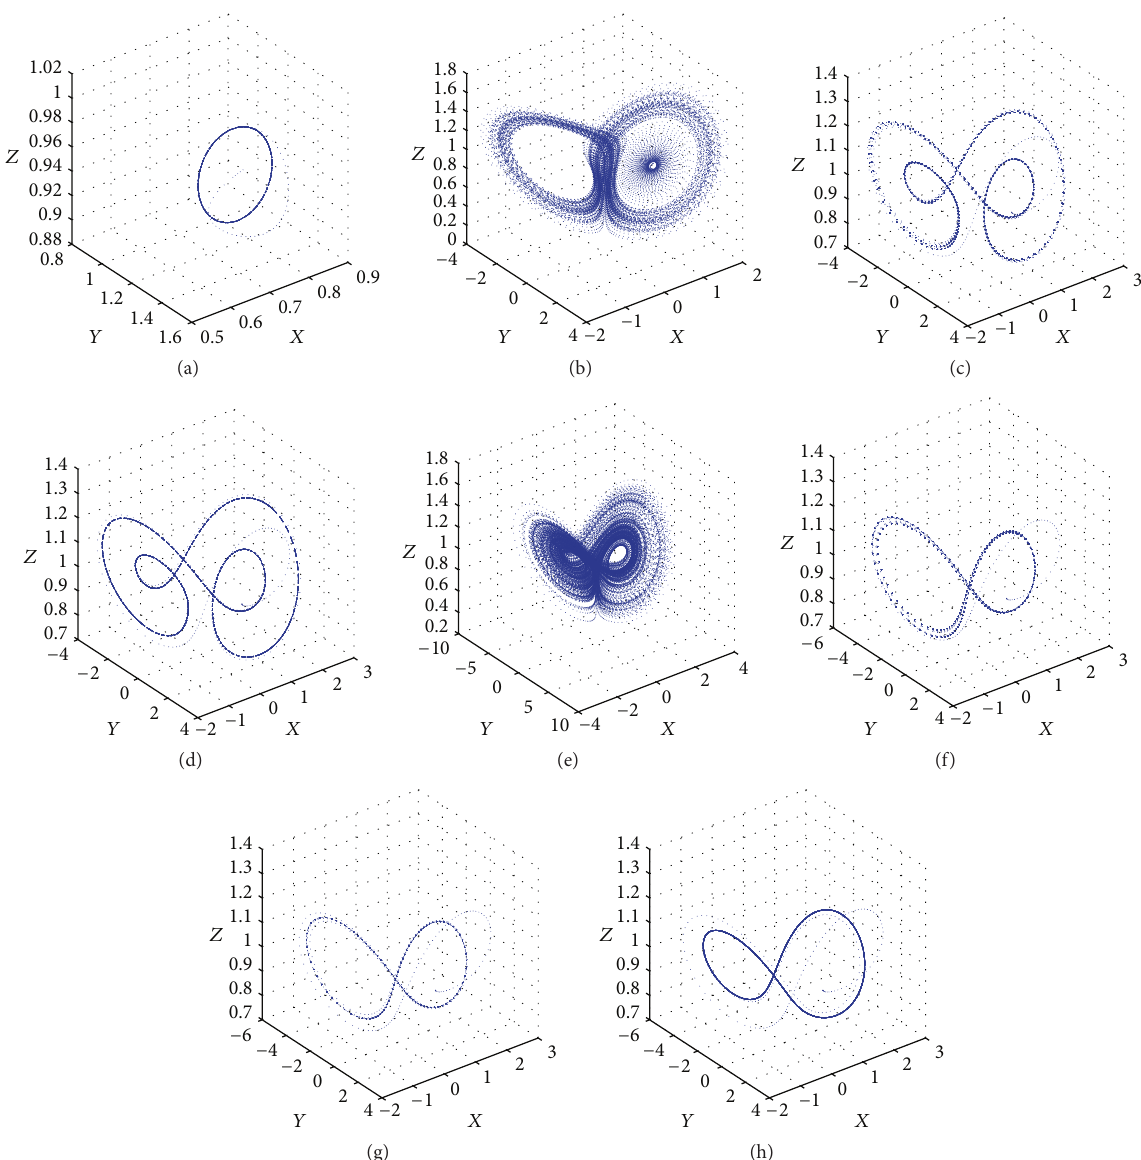
Figure 5: Phase portraits for (a) 𝑅 ≃ 46.37 , (b) 𝑅 = 48 , (c) 𝑅 = 250 , (d) 𝑅 = 260 , (e) 𝑅 = 300 , (f) 𝑅 = 360 , (g) 𝑅 = 400 , and (h) 𝑅 = 500 for the case where Le = 0.1 , 𝑅 𝑠 = 15 .